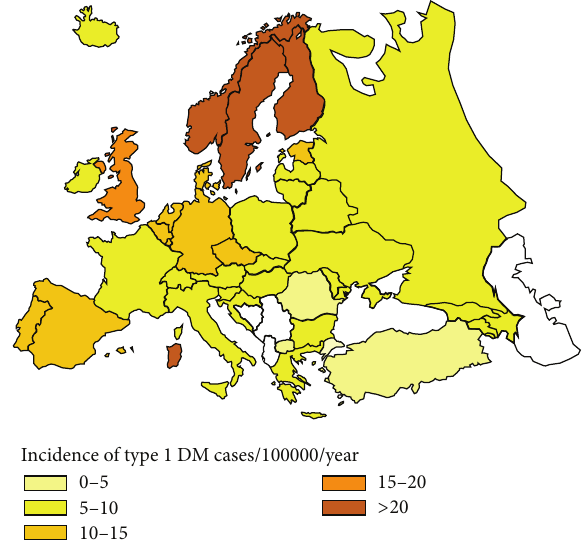
Figure 1: Incidence of type 1 diabetes in children up to 14 years of age/100000/year over the years 1990–1994